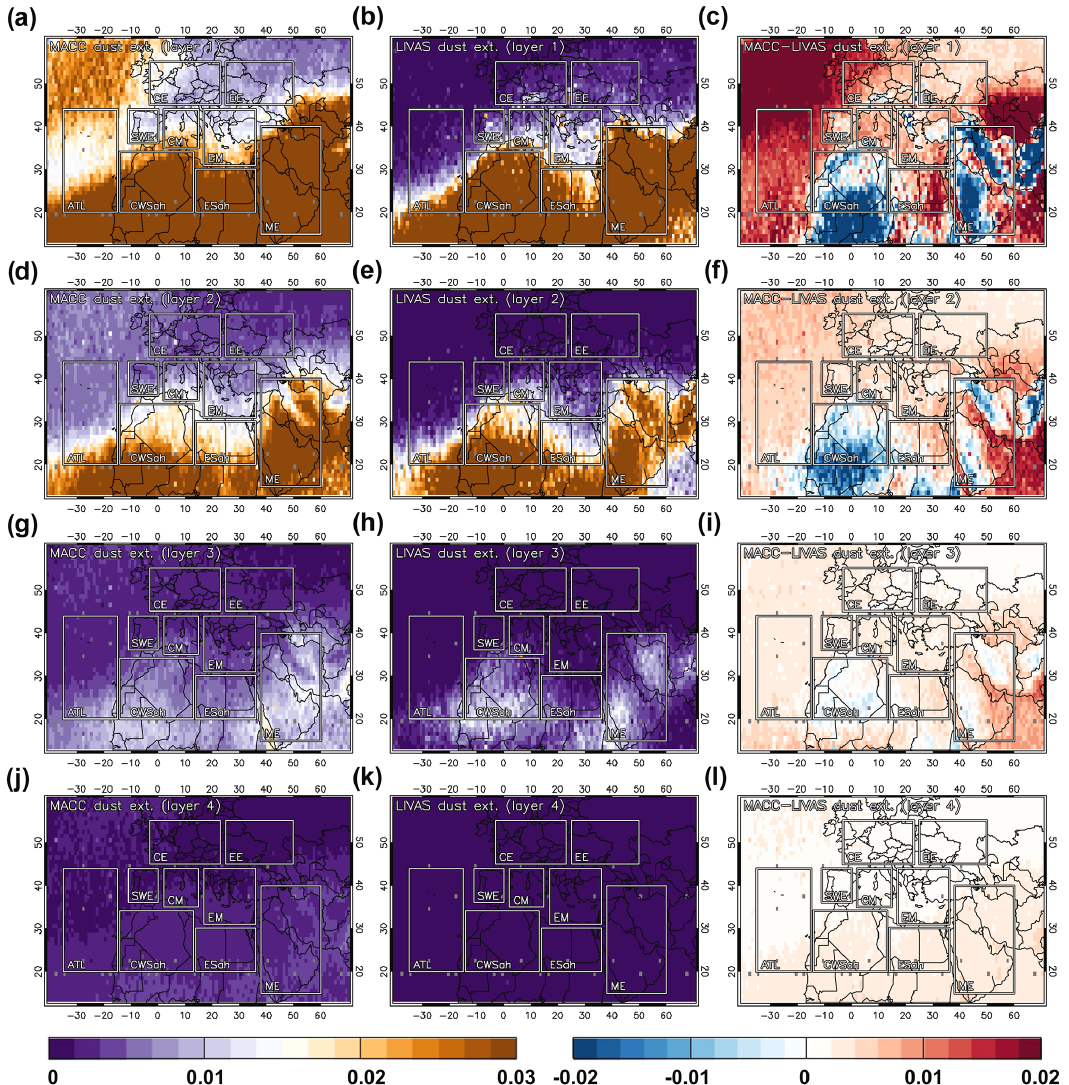
Figure 5. Patterns of the MACC average dust extinction coefficient at 550nm (in km − 1 ) (left column), the LIVAS average dust extinction coefficient at 532nm (in km − 1 ) (middle column) and the MACC–LIVAS mean bias (right column) over the Europe–northern Africa–Middle East domain for layer 1 (1200–3000ma.s.l.) (a, b, c) , layer 2 (3000–4800ma.s.l.) (d, e, f) , layer 3 (4800–6600ma.s.l.) (g, h, i) and layer 4 (6600–8400ma.s.l.) (j, k, l)